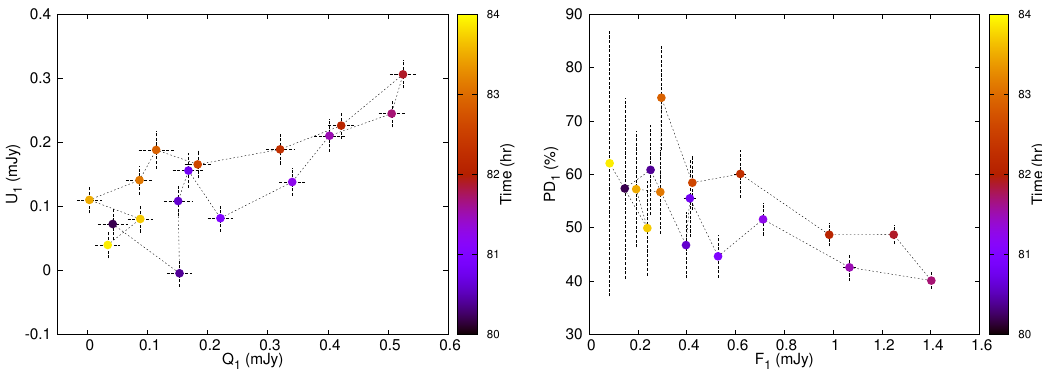
Figure 6. ( Left ): Evolution of Stokes’ parameter, Q and U, for the flare component; ( Right ): Flux-PD plot for the flare component